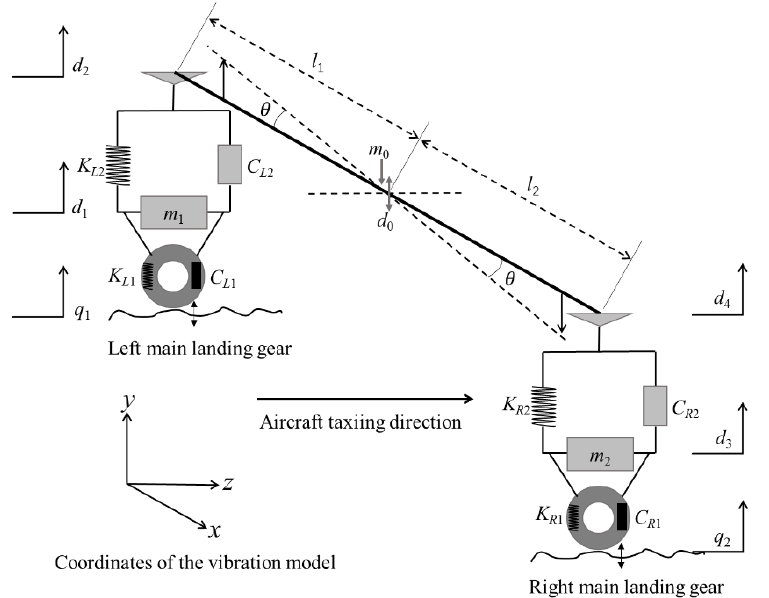
Figure 3. Simplified 4-DOF aircraft runway vibration model.